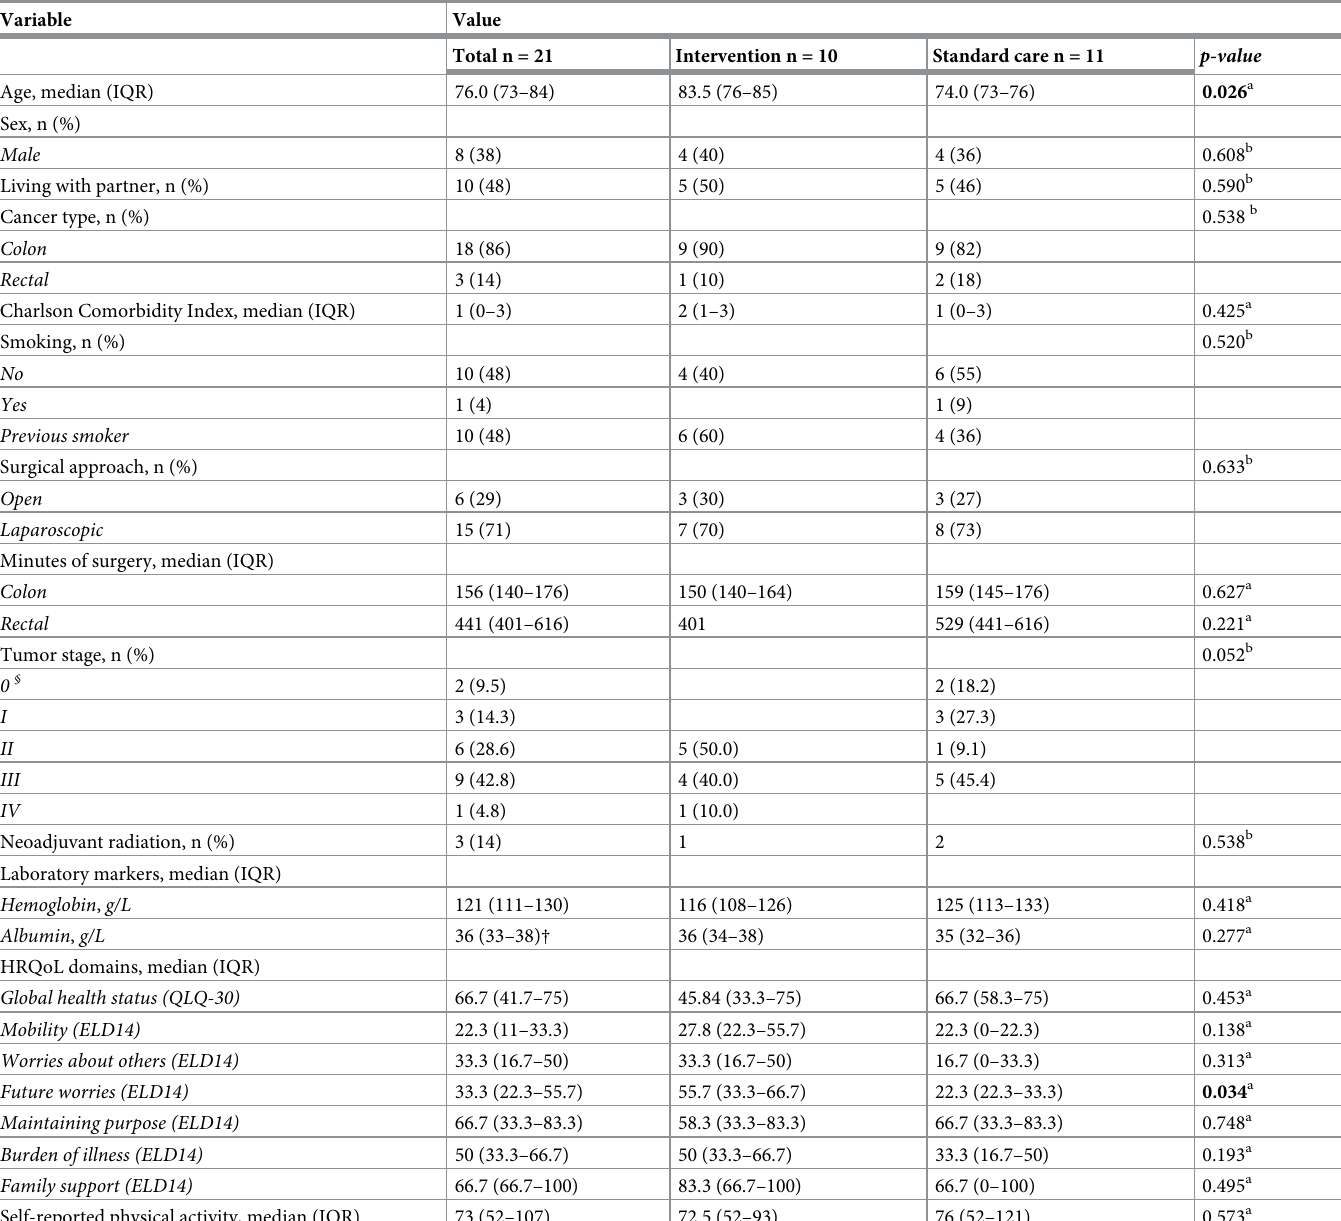
Table 1. Demographic and clinical characteristics per allocation